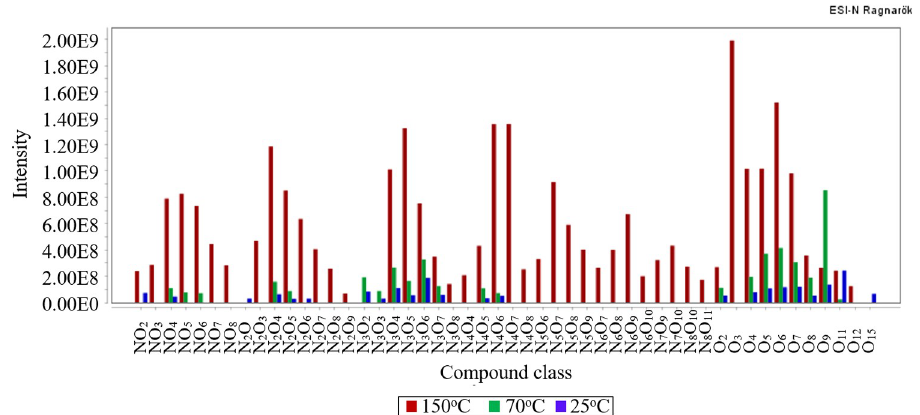
Fig 1. Relative abundance of heteroatom compound classes analysed with FTICR-MS, electrospray ionization in negative ion mode. Note the changes in MRP distribution after the reaction of glycine with Ipomoea longituba starch at 150˚C, 70˚C, and